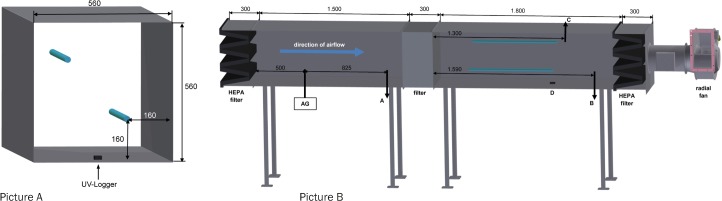
Scheme of the air filter test chamber.(Picture A) Cross section of the test chamber showing the position of both UVC tubes. (Picture B) Longitudinal section of the test chamber. The direction of airflow through the chamber is indicated by a blue arrow. The position of UVC tubes is given by two horizontal blue lines. Dimensions of the test chamber are given in mm. AG: aerosol generator, A: sampling point in front of the air filter, B: sampling point behind the air filter, C: measuring point for relative humidity in the test chamber, D: position of UV-logger.